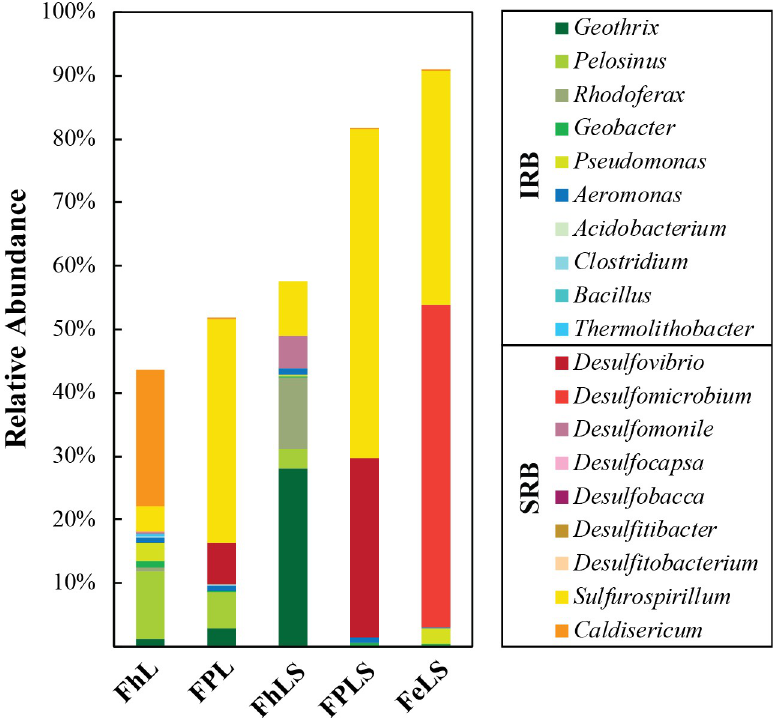
Fig 7. Diversity of iron- and sulfur/sulfate-reducing in Lake Pavin enrichment cultures with different Fe phases. Bacterial 16S rRNA gene sequences obtained from 2016 Lake Pavin enrichment cultures were classified based on best BLAST hit results, and putative iron- and sulfur/sulfate-reducing bacteria were identified based on phylogenetic affiliation with known iron and sulfur/sulfate reducers. Cultures were sequenced after significant evolution of the original added iron phase was observed: FhL = 360 d, FPL = 82 d, FhLS = 55 d, FPLS = 180 d, FeLS = 27